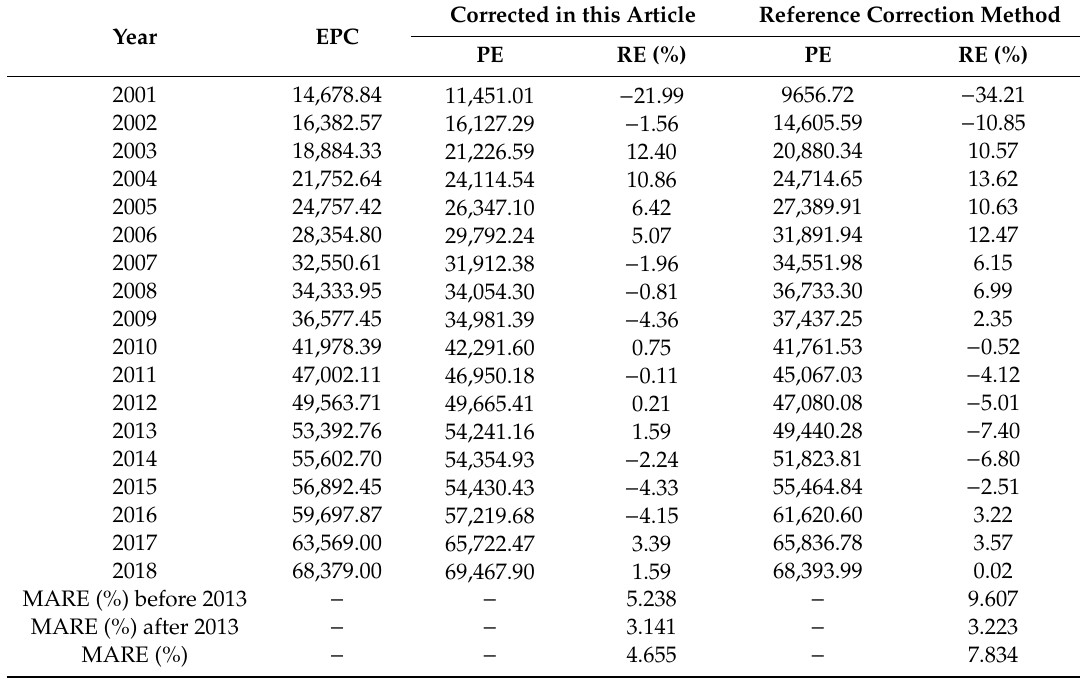
Table 4. Accuracy of the estimated statistical electric power consumption (EPC) in time series at the national scale by the established quadratic polynomial model.